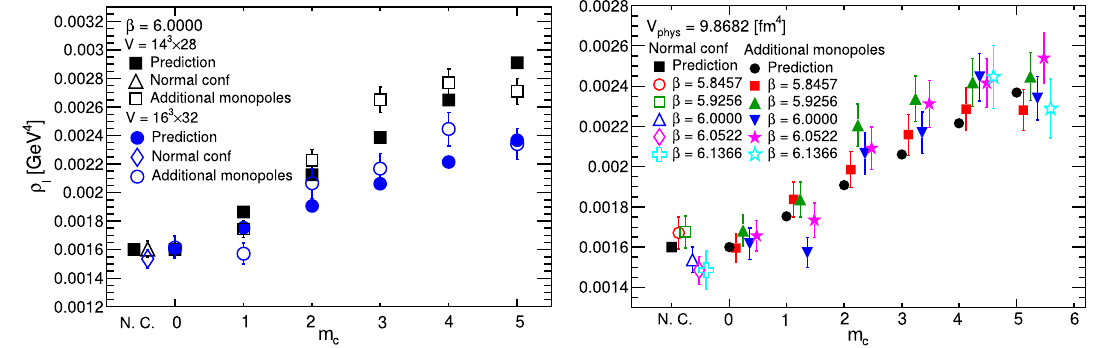
= 9 . 8682 [fm 4 ]. β = 6 . 0000 . The right panel shows the results of V phys The symbols in the right panel are slightly shifted along the horizontal axis to show the difference clearly